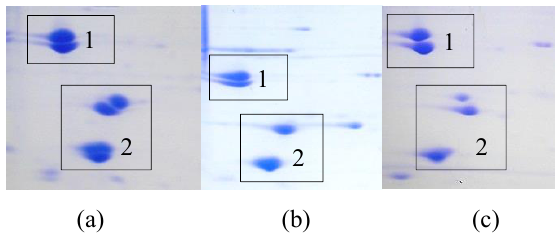
Fig. 1. Zones of tropomyosins and myosin light chains of M. Longissimus dorsi: (a) horse (Equus caballus); (b) pork (Sus scrofa); (с) beef (Bos taurus). The sections were cut out of gels whose decryption is presented in earlier published works [13, 14].